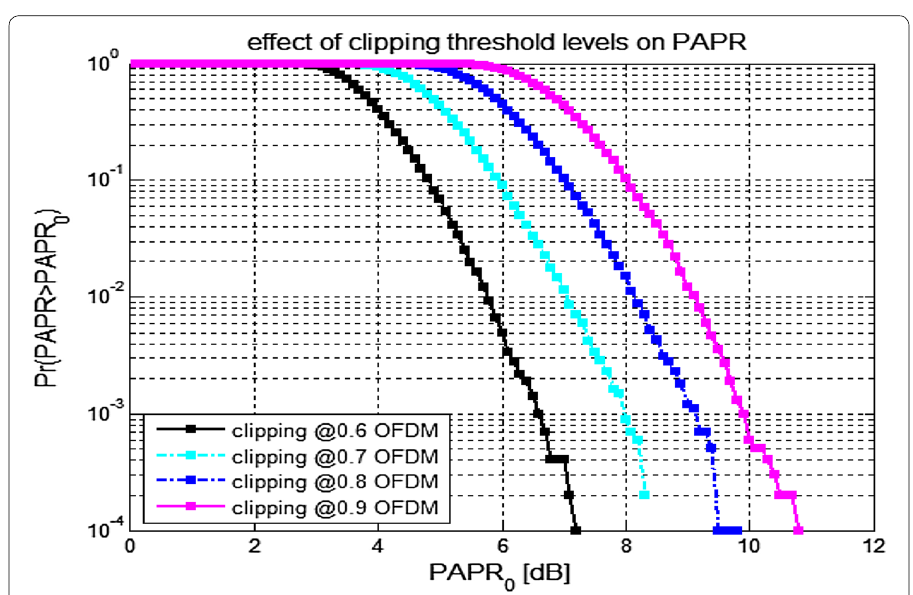
Fig. 3 CCDF of PAPR at different clipping